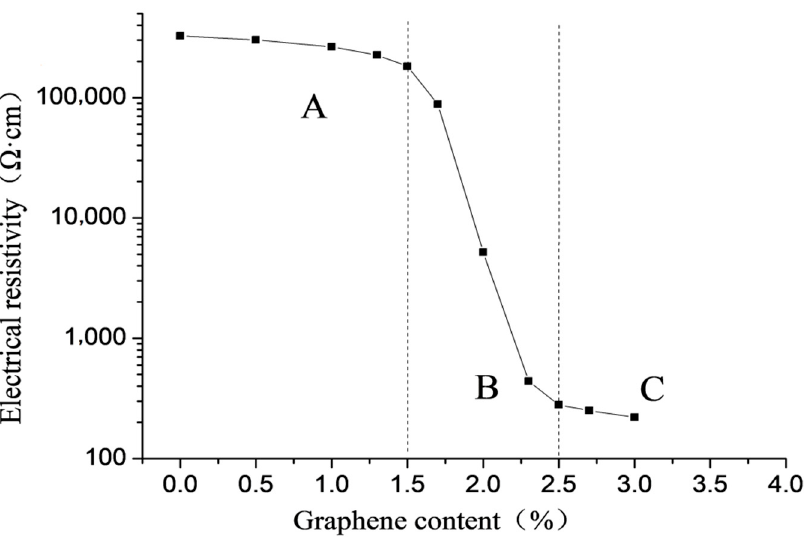
Figure 3. Relationship between electrical resistivity and graphene content of specimens without freeze–thaw action.